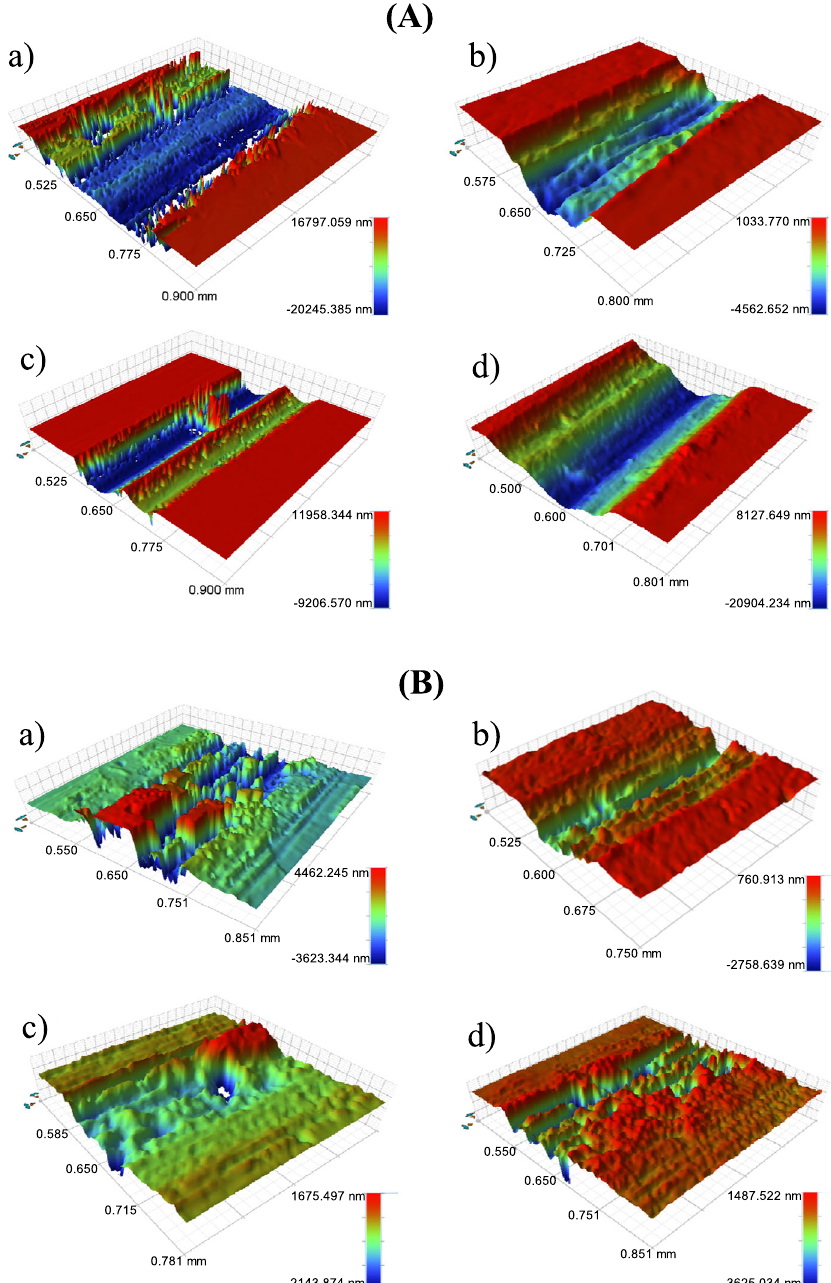
Fig. 6 A Surface topographies of wear tracks tested under dry sliding condition: ( a ) pure Zn; ( b ) Zn-0.5Li; ( c ) Zn-1Cu; and ( d ) Zn-1Ge; ( B ) Surface topographies of wear tracks tested under Hanks ’ solution condition: ( a ) Pure Zn; ( b ) Zn- 0.5Li; ( c ) Zn-1Cu; and ( d ) Zn-